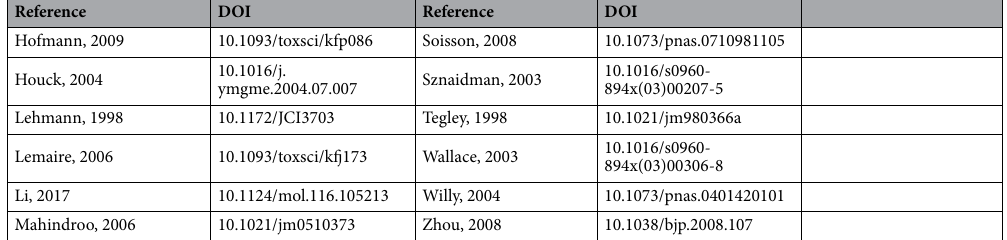
Table 1. The inferred EC50 values by the FACTORIAL NR assay vs. the literature data. The table shows the inferred EC50 values by the FACTORIAL NR assay vs. the literature data. The EC50 estimates by the FACTORIAL NR are average values of at least three independent replicate